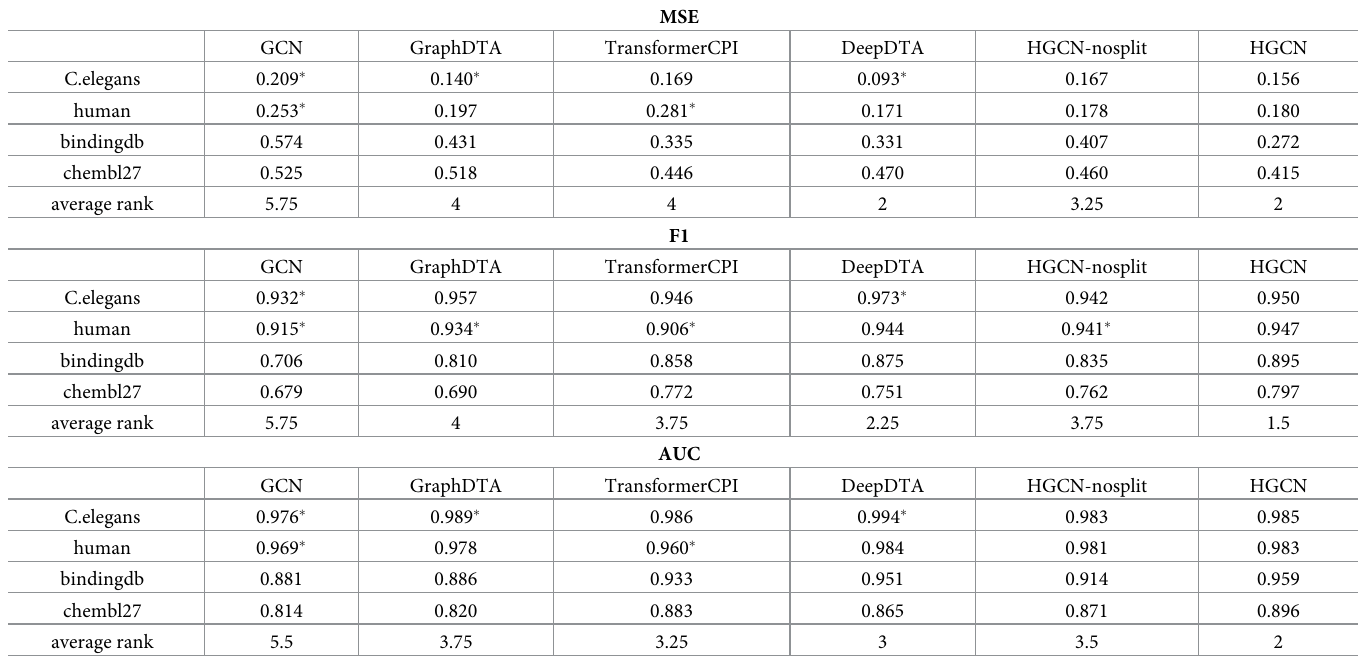
Table 4. MSE, F1 and AUC scores of CPI prediction models on the experimental